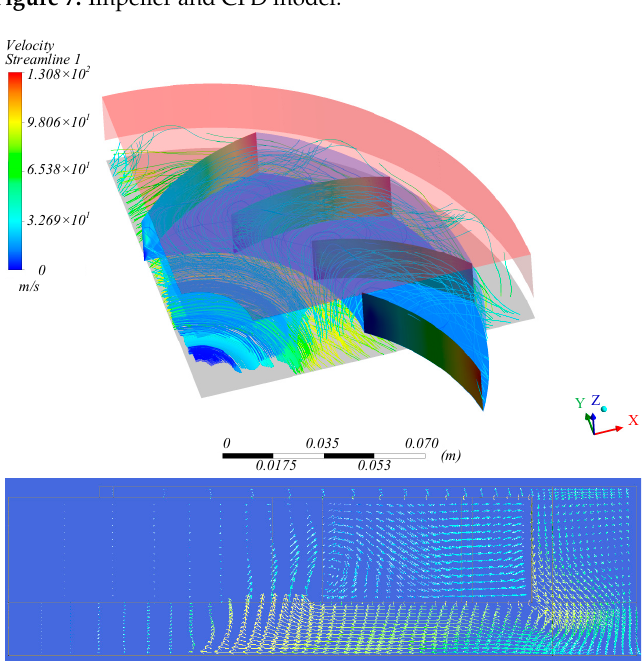
Figure 8. The flow pattern of the impeller.